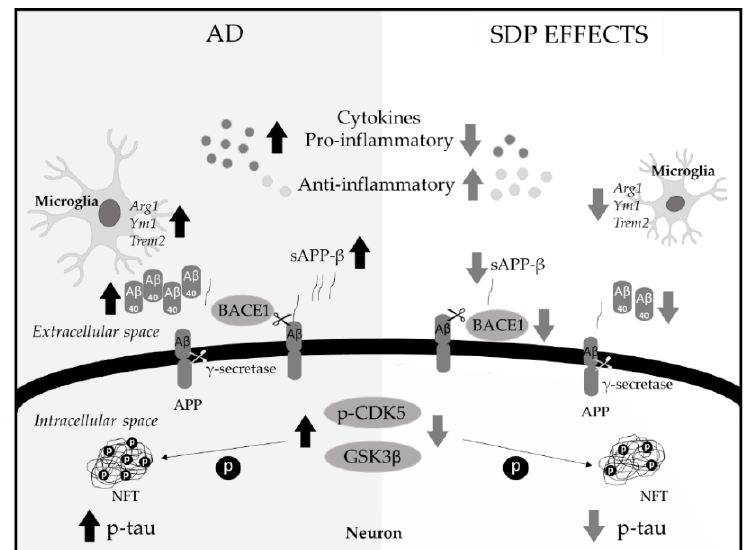
Figure 6. Representative scheme of the effects of SDP on AD hallmarks. SDP supplementation decreases the aberrant APP processing pathway and the hyperphosphorylation of tau. These preventive effects are accompanied by a reduction in the neuroinflammation and an attenuation in the activated microglia. APP: amyloid precursor protein, Arg1: arginase1, Aβ 40 : β-Amyloid 1-40, BACE1: β-secretase, CDK5: cyclin-dependent kinase 5, GSK3β: glycogen synthase kinase 3β, NFT: neurofibrillary tangles, P: phosphorylation, Trem2: triggering receptor expressed on myeloid cells 2, Ym1: chitinase-like protein 3